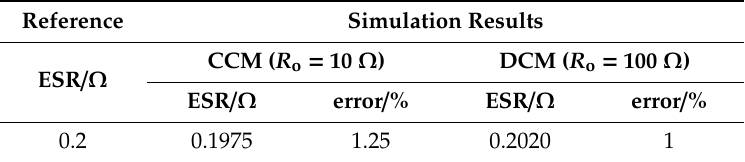
Figure 6. Signal processing waveforms of Buck converter in ideal condition: ( a ) CCM; ( b ) DCM. Table 2. ESR Simulation Results of Buck Converter by Method